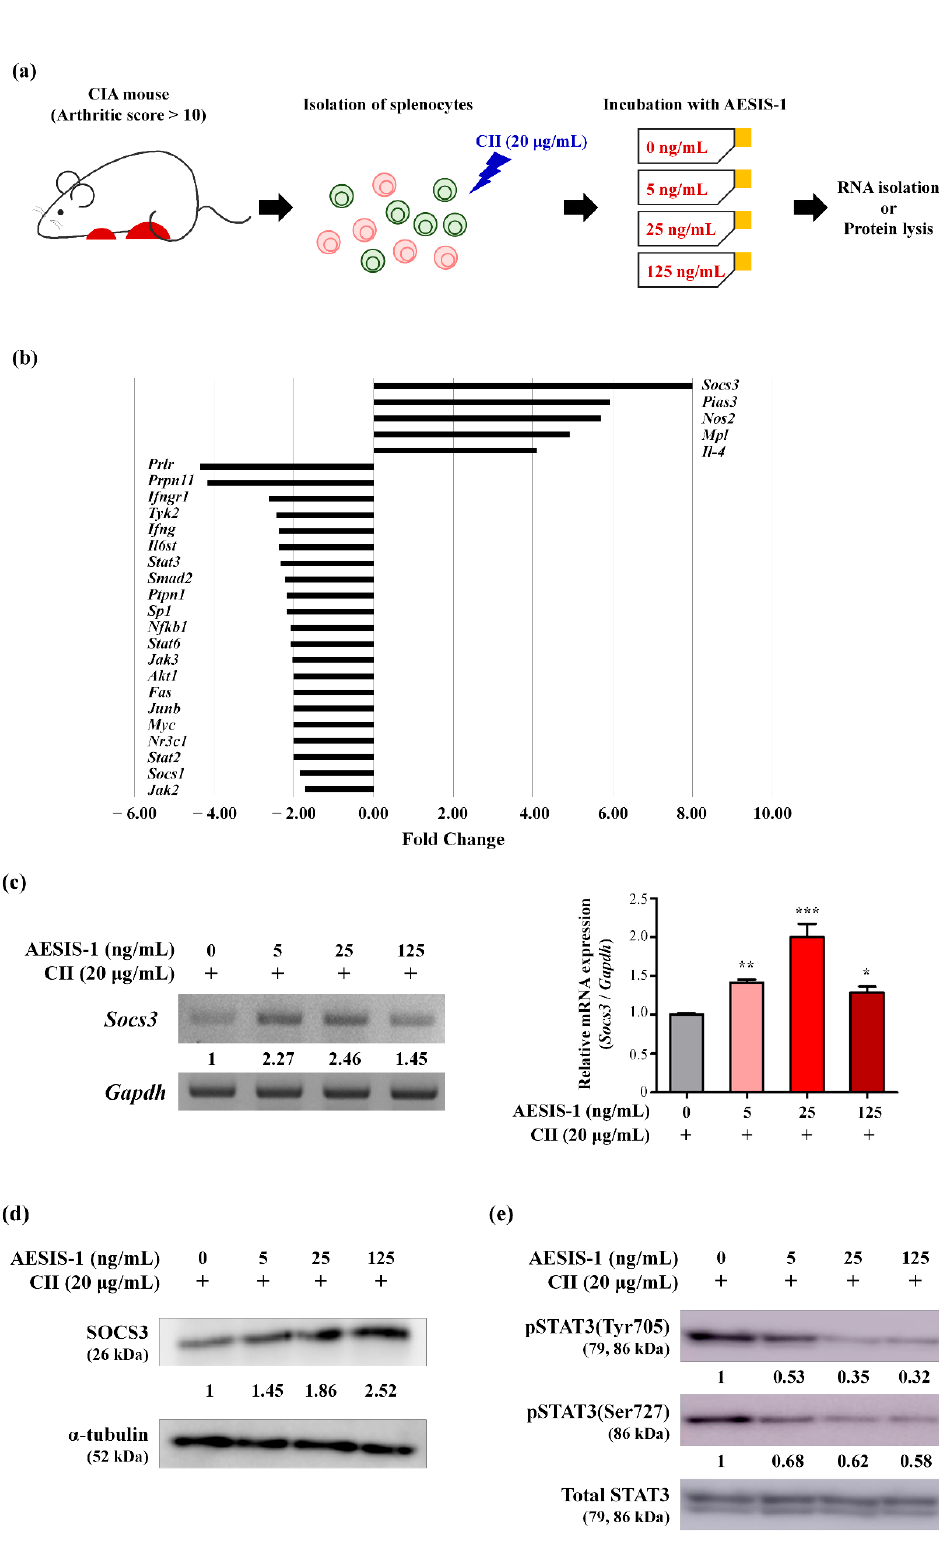
Figure 3. AESIS-1 directly increased SOCS3 expression, resulting in decreased STAT3 phosphorylation. ( a ) Scheme of in vitro experiments. Splenocytes were isolated from CIA mice with an arthritic score > 10, and the isolated splenocytes were then incubated with or without AESIS-1 in the presence of 20 µ g / mL CII. After incubation for 24 h, total RNA or protein were isolated from the cells; ( b ) To detect JAK / STAT-signaling-related gene expression, total RNA was extracted from CII-treated (20 µ g / mL) splenocytes from CIA mice that were incubated with or without AESIS-1 (25 ng/mL) for 24 h. The RT 2 Profiler PCR Array containing primers for 84 genes related to JAK/STAT signaling was then used to compare the gene expression levels in negative control cells vs. AESIS-1- treated cells; ( c ) To further confirm the effect of AESIS-1 on Socs3 gene expression, reverse- transcription PCR (RT-PCR) and real-time RT-PCR (qRT-PCR) were performed. The relative mRNA expression level was set to 1 for control cells without AESIS-1. ANOVA with Tukey’s post hoc tests was used for statistical analysis. * p ≤ 0.05, ** p ≤ 0.01, and *** p ≤ 0.001, compared with control cells without AESIS-1; ( d ) The effect of AESIS-1 on SOCS3 protein expression was confirmed by western blot analysis. Western blot analysis with rabbit anti-mouse SOCS3 and α -tubulin antibodies was performed to detect the levels of each protein; ( e ) The effect of AESIS-1 on STAT3 phosphorylation was confirmed by western blot analysis using rabbit anti-mouse phospho-STAT3 (Tyr705), rabbit anti- mouse phospho-STAT3 (Ser727), and rabbit anti-mouse total STAT3 antibodies. Full-length blots of the cropped image as shown in Figure 3d,e are presented in Figure S2. 2.4. AESIS-1 Suppressed IL-17 Production and Th17 Cell Populations The activation of STAT3 plays a critical role in Th17 cell differentiation, and IL-6 stimulates STAT 3 activation [21]. Specifically, IL-6 plays a critical role in RA pathogenesis by contributing to Th17 cell differentiation. Therefore, IL-6 and IL-17 levels in the mouse sera from normal, vehicle-treated, and AESIS-1-treated groups were measured using a cytokine array. Figure 4a shows that AESIS-1 significantly reduced the increases in both proinflammatory cytokines in sera from vehicle-treated mice. The relative levels of IL-6 and IL-17 were increased in the vehicle-treated CIA mice compared with the normal mice; however, the increased levels were significantly decreased by AESIS-1. Next, we examined the amount of IL-17 produced by splenocytes and the distribution of Th17 cells in affected tissues from vehicle- or AESIS-1-treated CIA mice. The data showed obviously increased IL- 17 production in supernatants of splenocytes cultured from vehicle-treated CIA mice ex vivo, and significantly reduced production in those from CIA mice treated with AESIS-1 (Figure 4b). Consistent